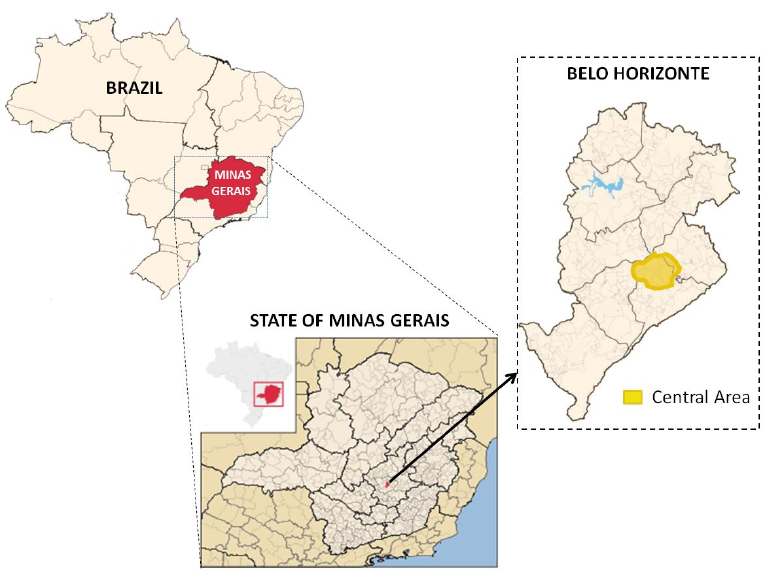
Figure 2: Geographic location of Belo Horizonte city and the study